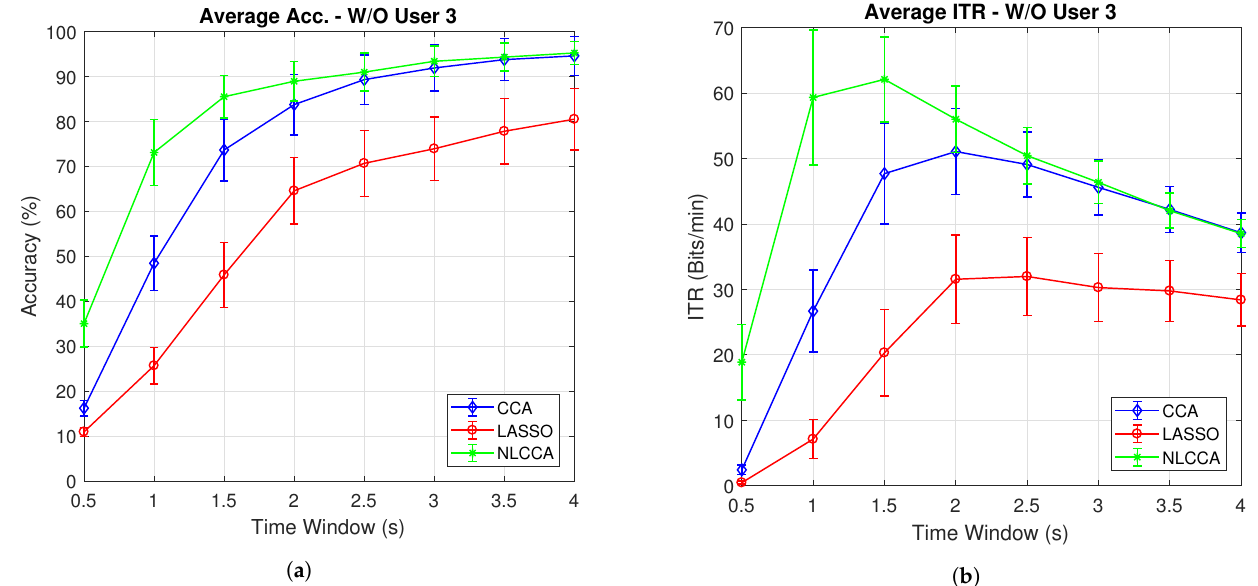
Figure 8. Comparison of ( a ) average accuracy and ( b ) average ITR (excluding User 3) between CCA, LASSO, and